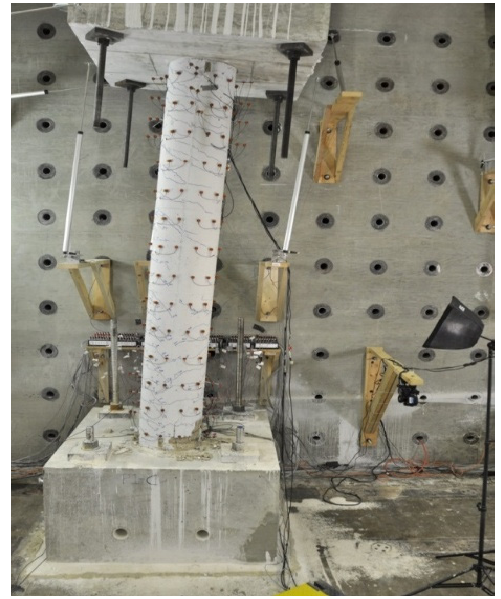
Figure 8. A photo of the concrete column yielding after test.